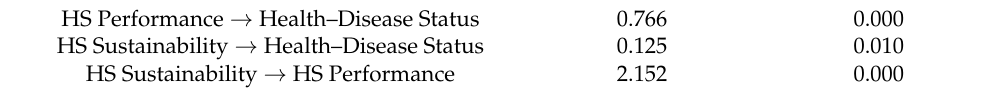
Table 10. Effect sizes ( f 2 ) and p